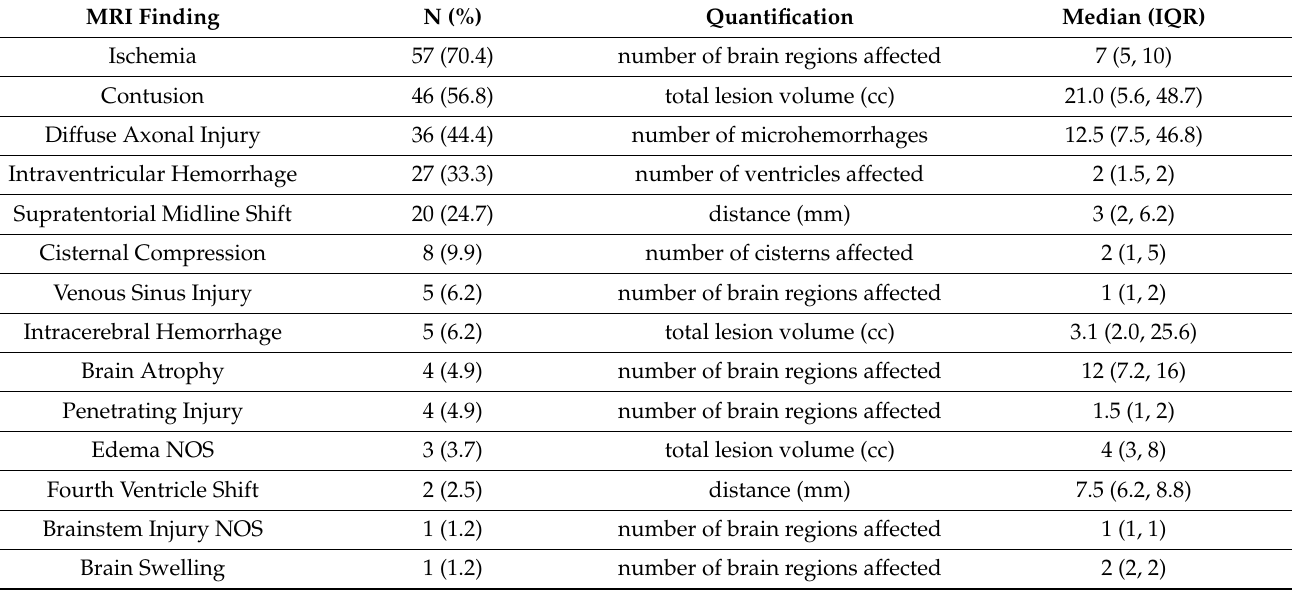
Table 2. Prevalence and quantification of MRI findings.